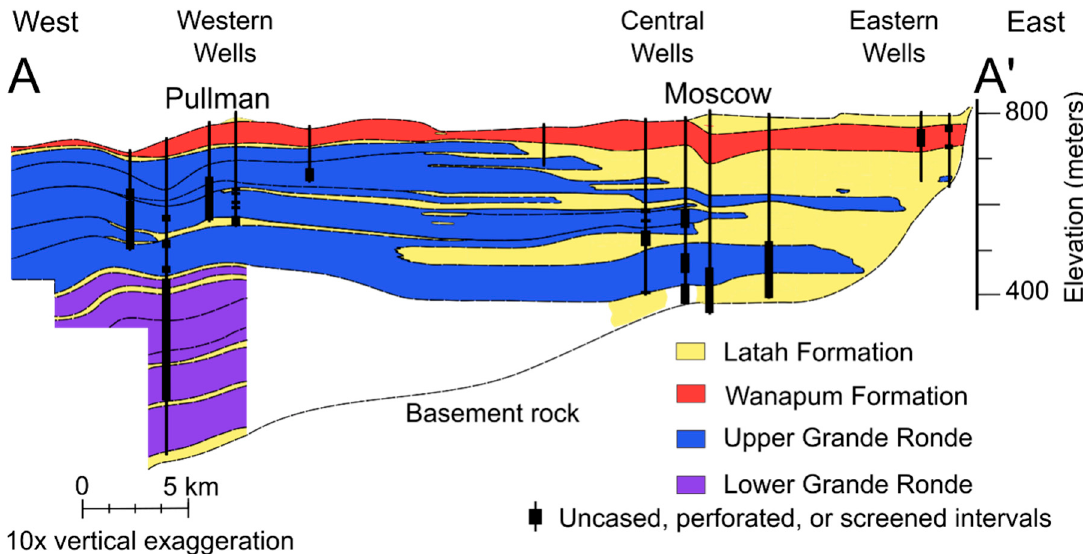
Figure 2. A west-to-east cross section of the South Fork Palouse River Basin from Pullman, Washington, to Moscow, Idaho (transect A–A’ outlined in Figure 1) and select wells sampled during this study to indicate typical well depths and screened intervals in the three well groupings—Western, Central and Eastern.